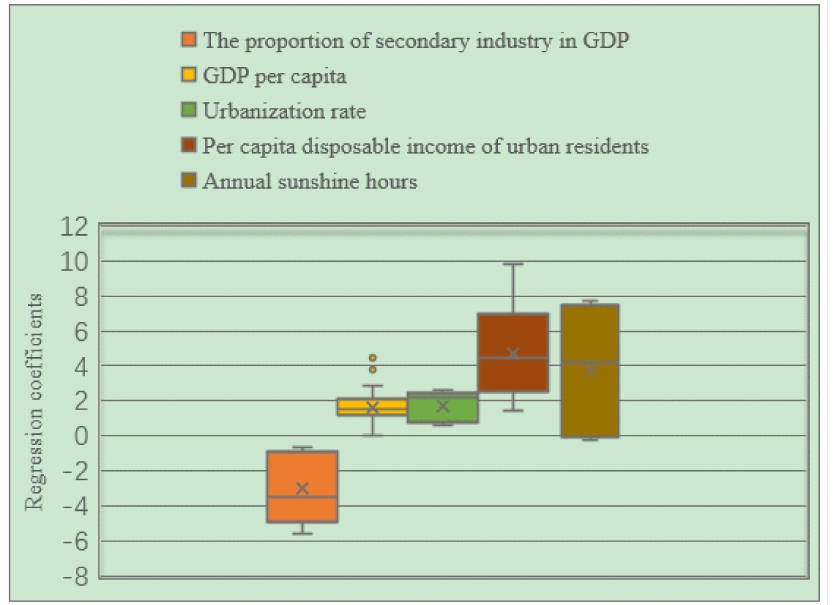
Figure 18. Box plot of GWR model regression coefficient distribution of EPC in the three major urban agglomerations of the YREB in 2013.